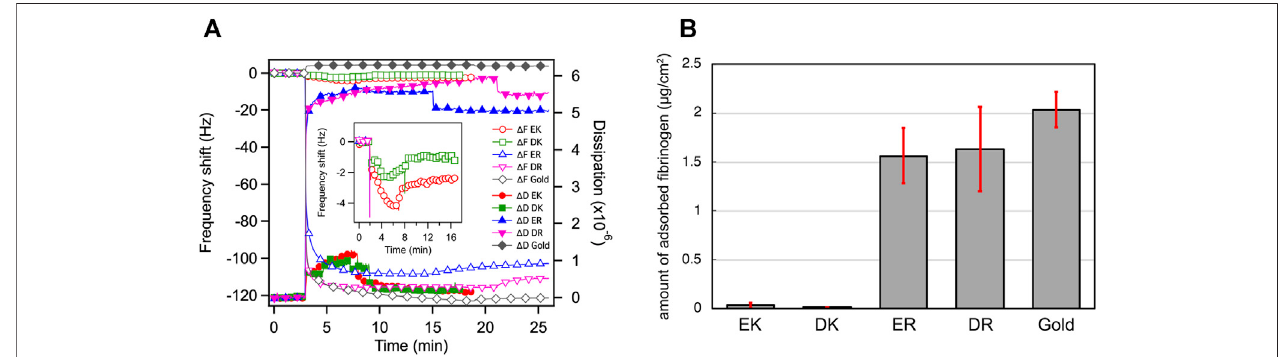
FIGURE2|(A) QCMchart(frequencyanddissipation)observedforadsorptionof fi brinogenontothepeptide-SAMs.RinsingwithPBSwereperformedat8,9,15, 21, 17 min for EK, DK, ER, DR, and bare gold, respectively. (B) The amount of adsorbed fi brinogen on peptide-SAMs in the PBS solution measured by QCM-D. Error bars denote standard deviation ( n (cid:2) 3).